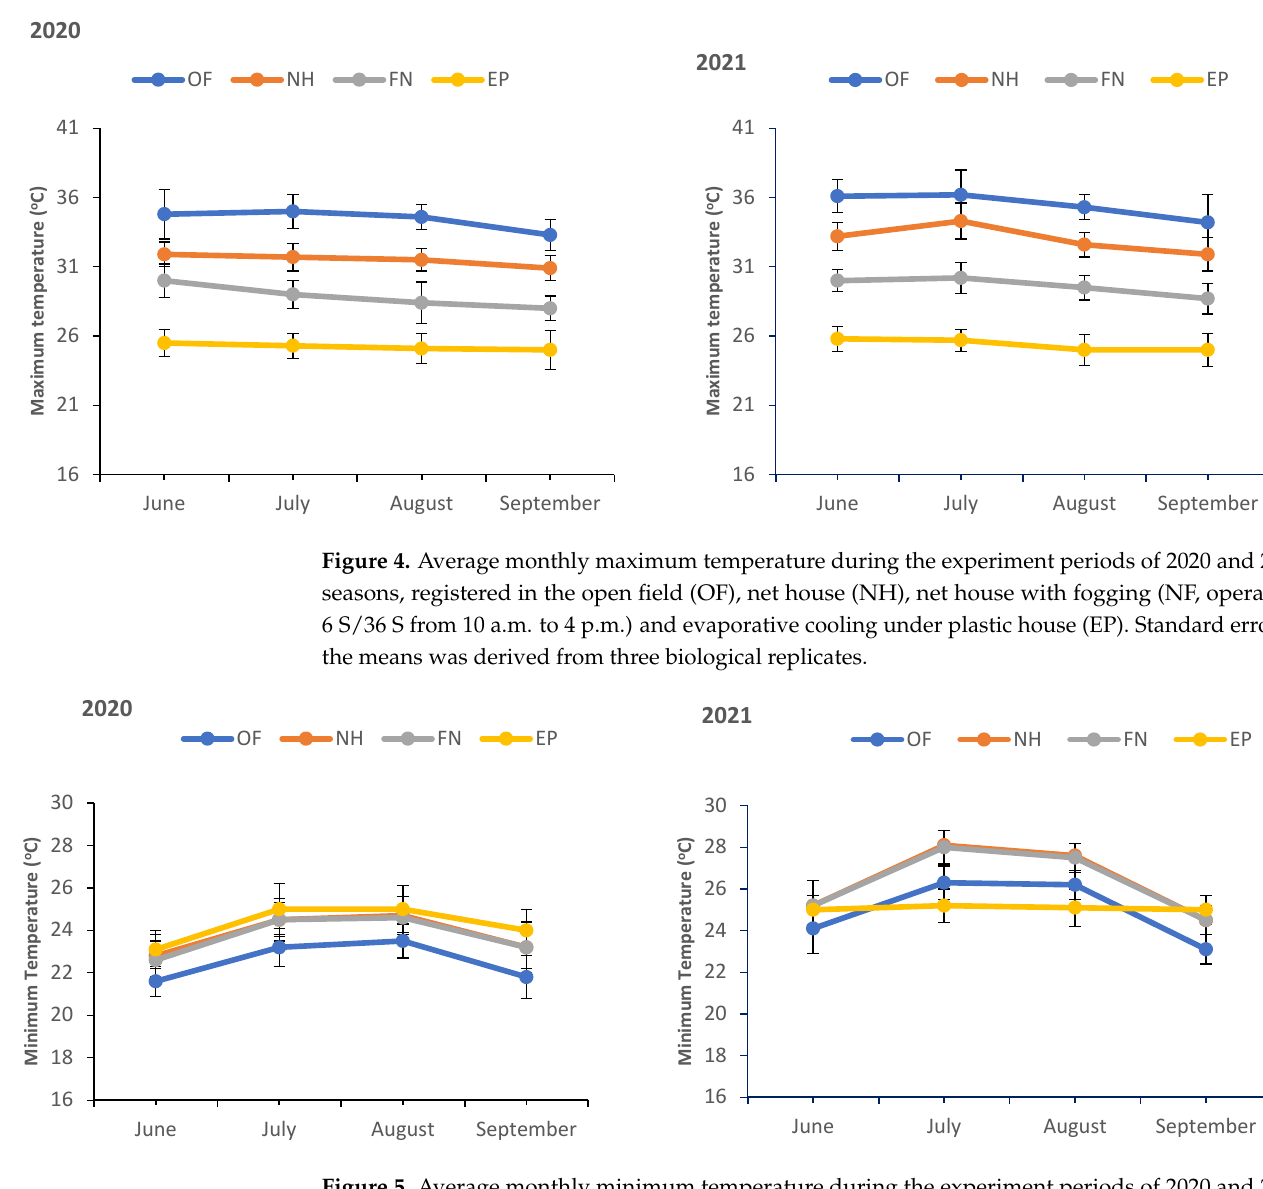
Figure 5. Average monthly minimum temperature during the experiment periods of 2020 and 2021 seasons, registered in the open field (OF), net house (NH), net house with fogging (NF, operating 6 S/36 S from 10 a.m. to 4 p.m.) and evaporative cooling under plastic house (EP). Standard error of the means was derived from three biological replicates.